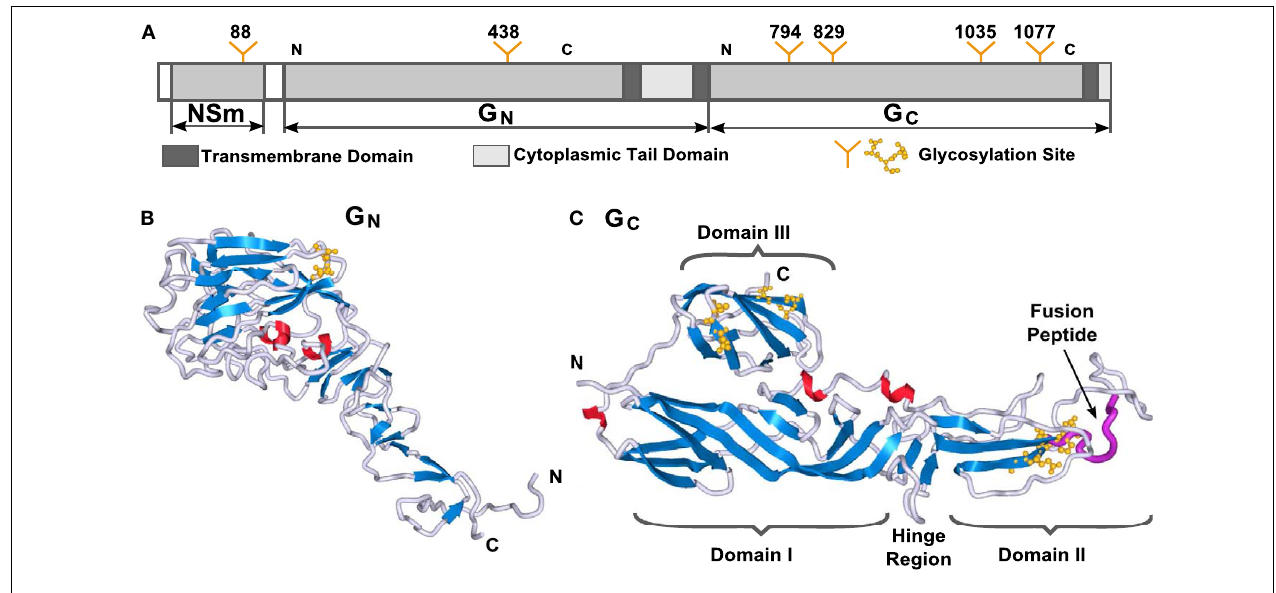
RVFV (B) Gn and (C) Gc are shown. Secondary structures are highlighted in blue for β -strands, red for α -helices, and gray for turns.The predicted location of the fusion peptide within Gc is represented in purple.The domain nomenclature in modeled Gc were used in adoption to the alphavirus E1 protein.The molecular graphics in this paper were generated with Sculptor (Birmanns et al., 2011) and Chimera (Pettersen et al.,